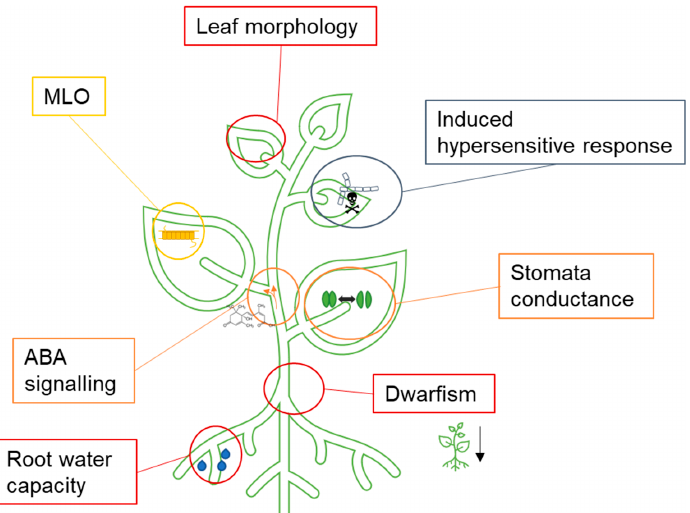
Figure 2. Overview of target points addressed with NGT for the traits of drought tolerance and pathogen resistance. Red, morphological changes from drought tolerance; orange, intracellular changes from drought tolerance; blue, R genes; and yellow, S genes. MLO, Mildew Locus O, ABA, Abscisic acid.